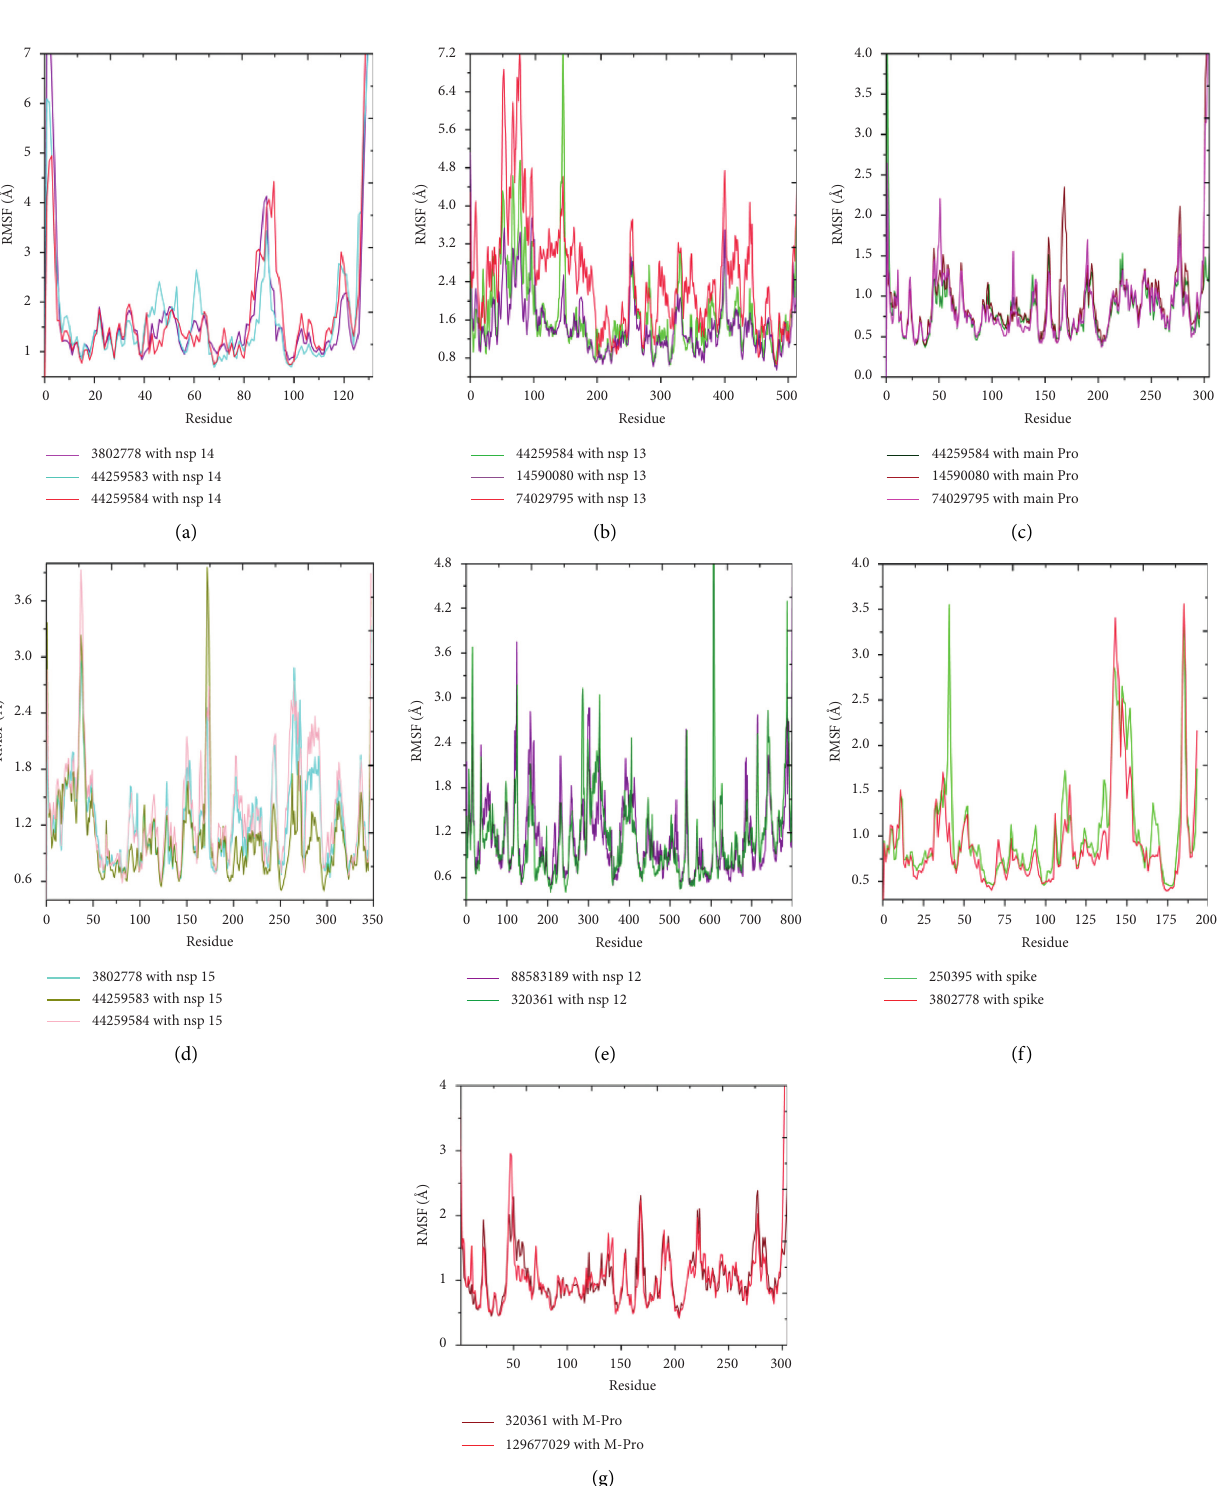
Figure 8: RMSF plots of SARS-CoV-2 proteins and screened compound complexes. Nsp14 (a), Nsp13 (b), main protease (c), Nsp15 (d), Nsp12 (e), spike (f), and membrane protein